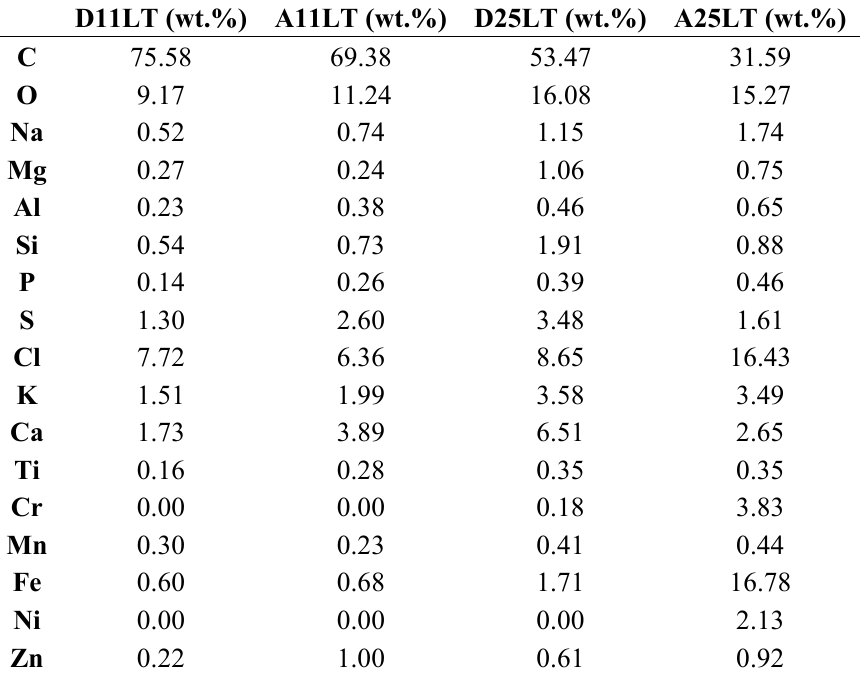
Table 5. SEM-EDS results of the average of three analysis from each of the samples. (D) deposited fouling, (A) adhered fouling, (LT) low deposition probe temperature, (11) 11 m 3 /h and (25) 25 m 3